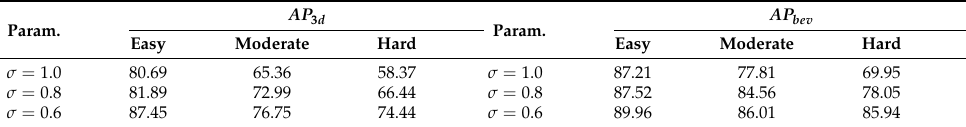
Table 6. Results for hyper-parameters. σ controls the numbers of positive and negative samples during training. When σ = 1, each ground truth corresponds to the peak of the Gaussian label, i.e., only one positive sample. AP 3 d Param. Param.